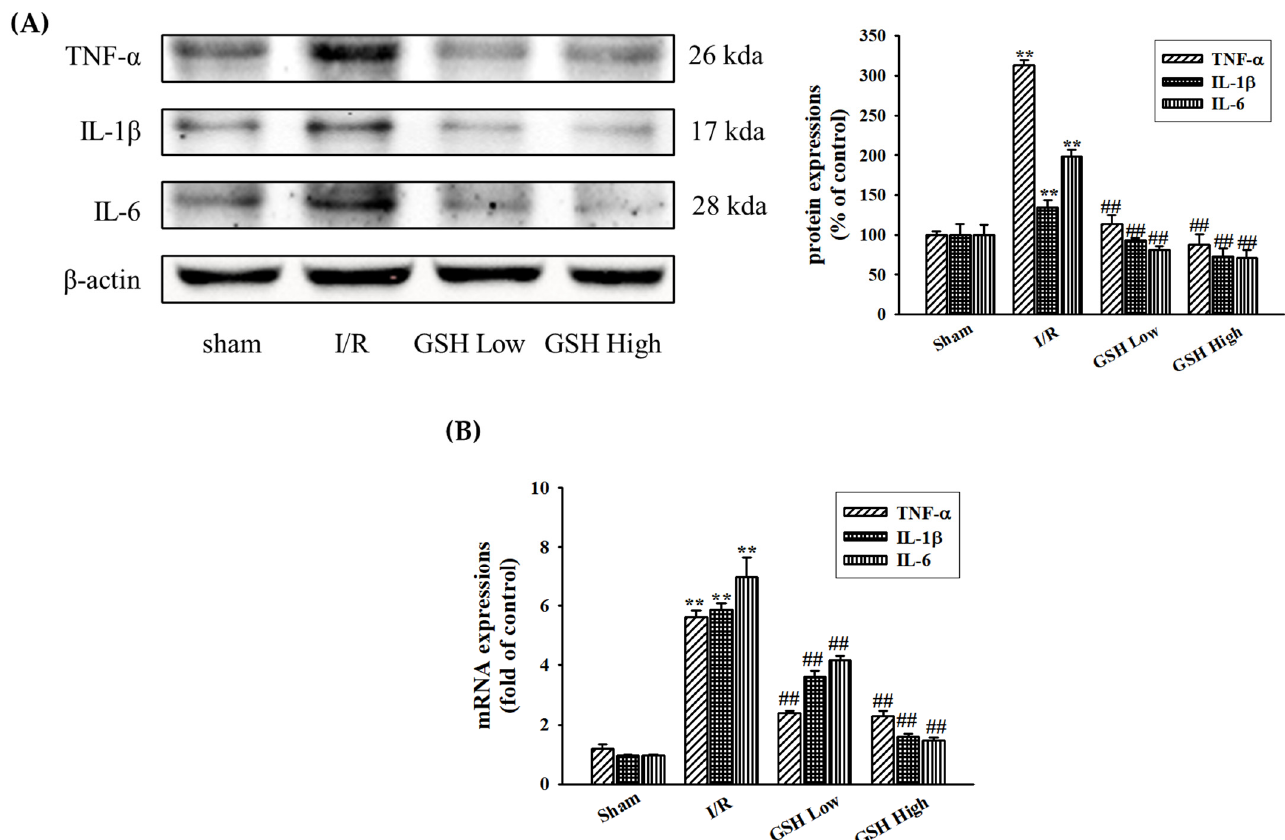
Figure 5. Effects of GSH on proinflammatory cytokines’ expressions in kidney. Protein expressions of cytokines such as TNF- α , IL-1 β , and IL-6 were determined by Western blot analysis ( A ). Relative mRNA expression was calculated by real-time RT-qPCR ( B ). Data are presented as means ± SE ( n = 3). ## p < 0.01 vs. sham (normal) group; ** p < 0.01 vs. I/R group.